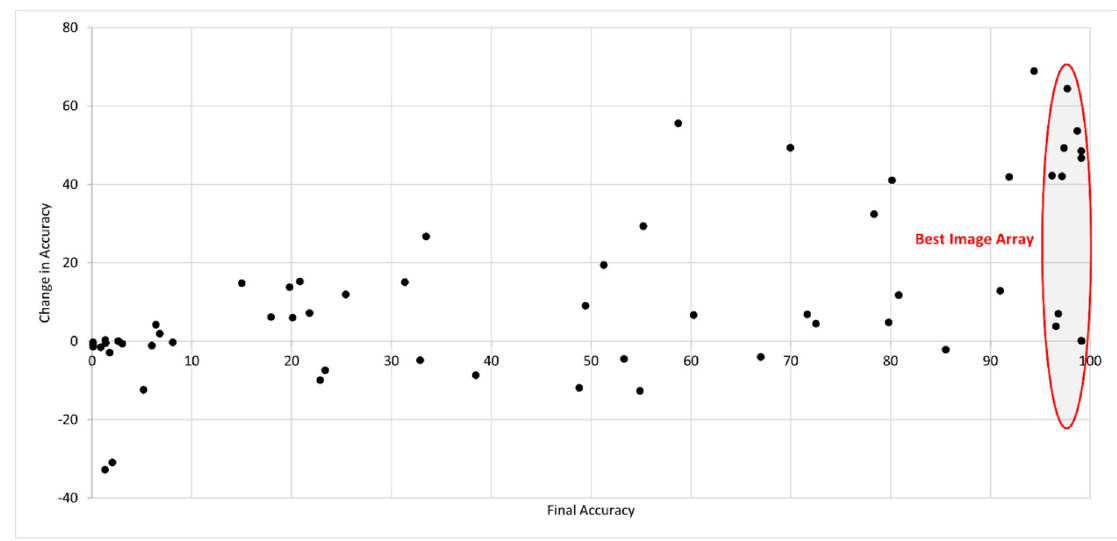
Figure 11. SEDIQA’s effect on OCR Accuracy for document D1 of the SmartDoc dataset. Again, the system only retains those images in the Best Image Array for conversion to text but the full results across all versions of the document are presented here.